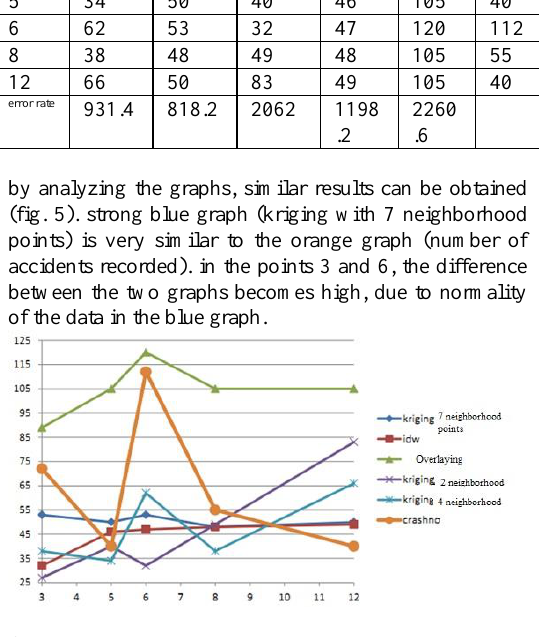
figure. 5 graph showing error changes process in the control